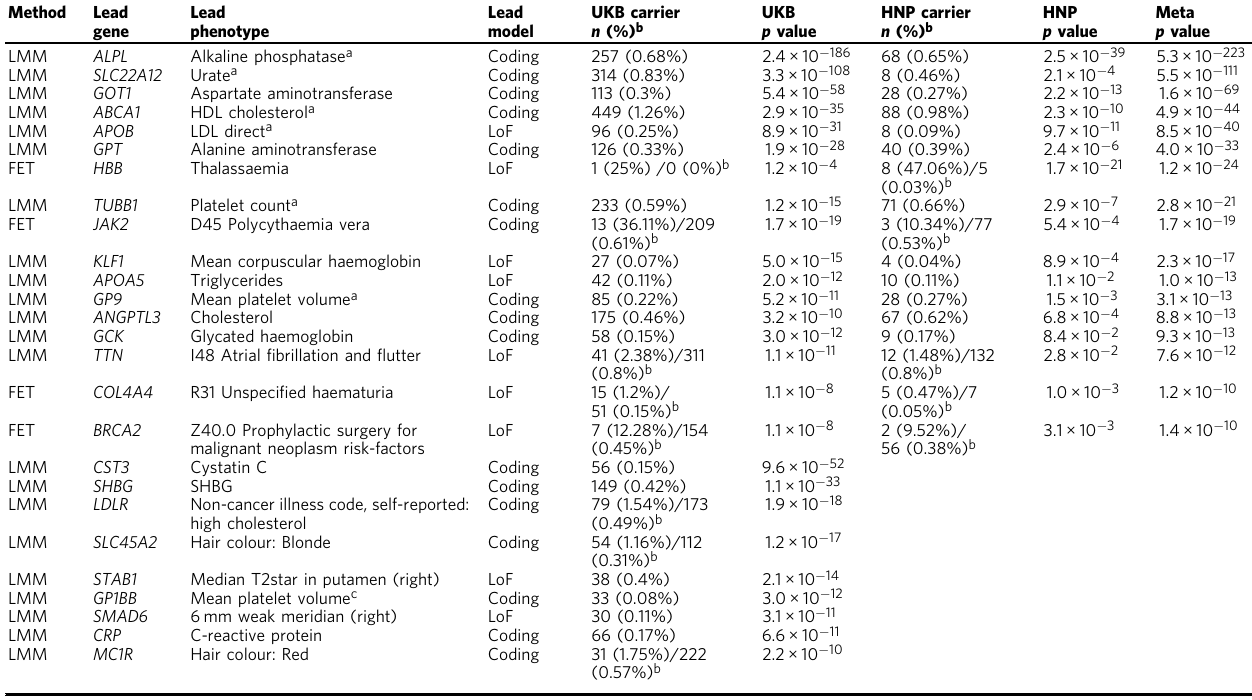
Table 2 Statistically signi fi cant associations from the European ancestry analysis.